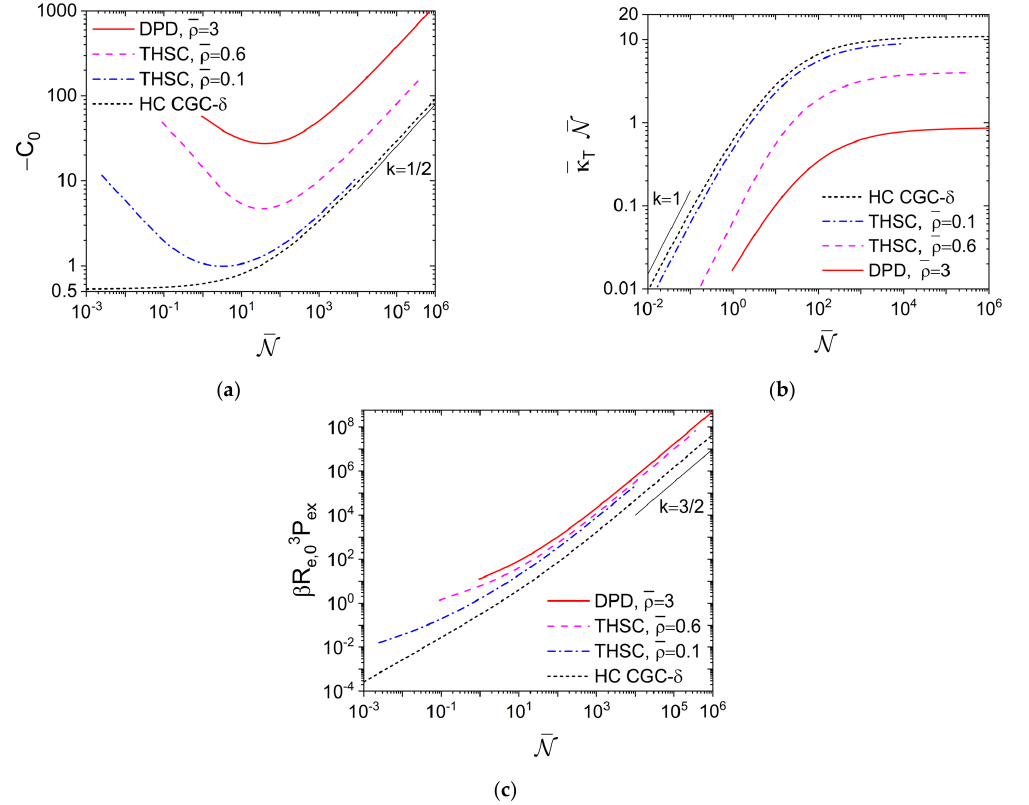
Figure 1. Logarithmic plot of ( a ) C 0 , ( b ) normalized isothermal compressibility κ T , and ( c ) excess (virial) pressure due to the interchain repulsion P ex vs. the invariant degree of polymerization N of various models. The k ‐ value gives the slope of the corresponding straight line. See the main text for more details. With the normalized isothermal compressibility